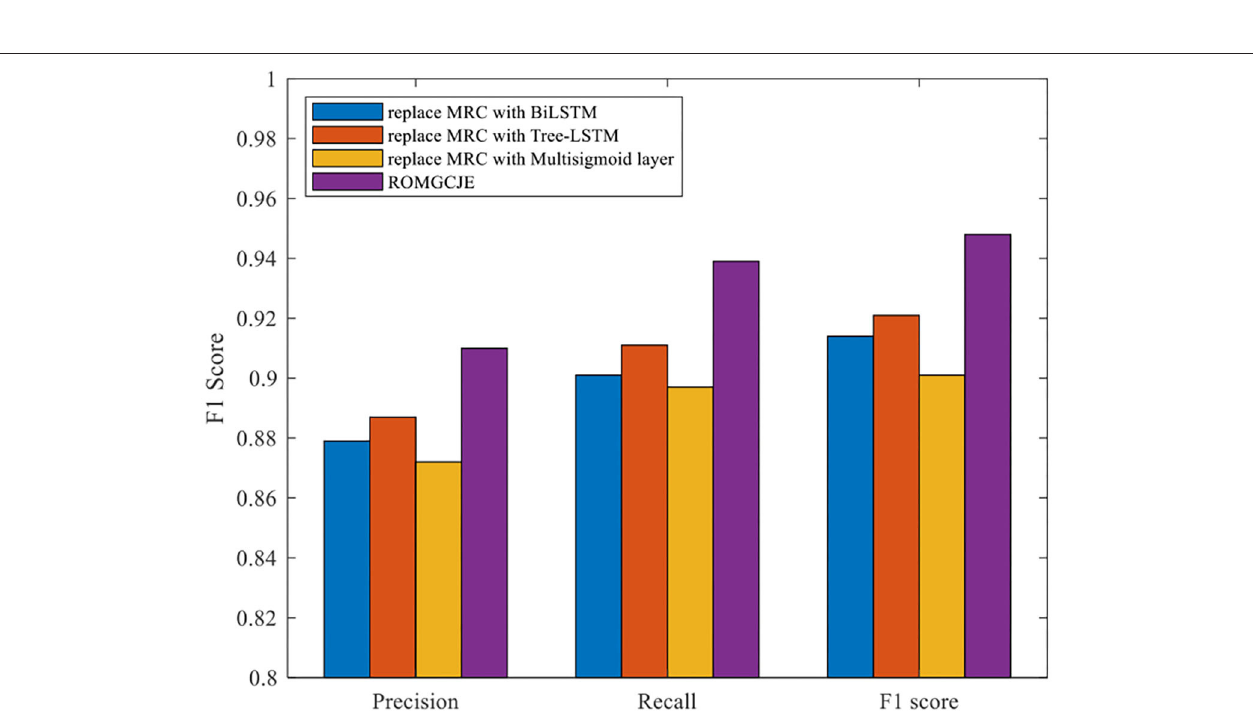
FIGURE 9 | Ablation experiments for MRC on the NYT